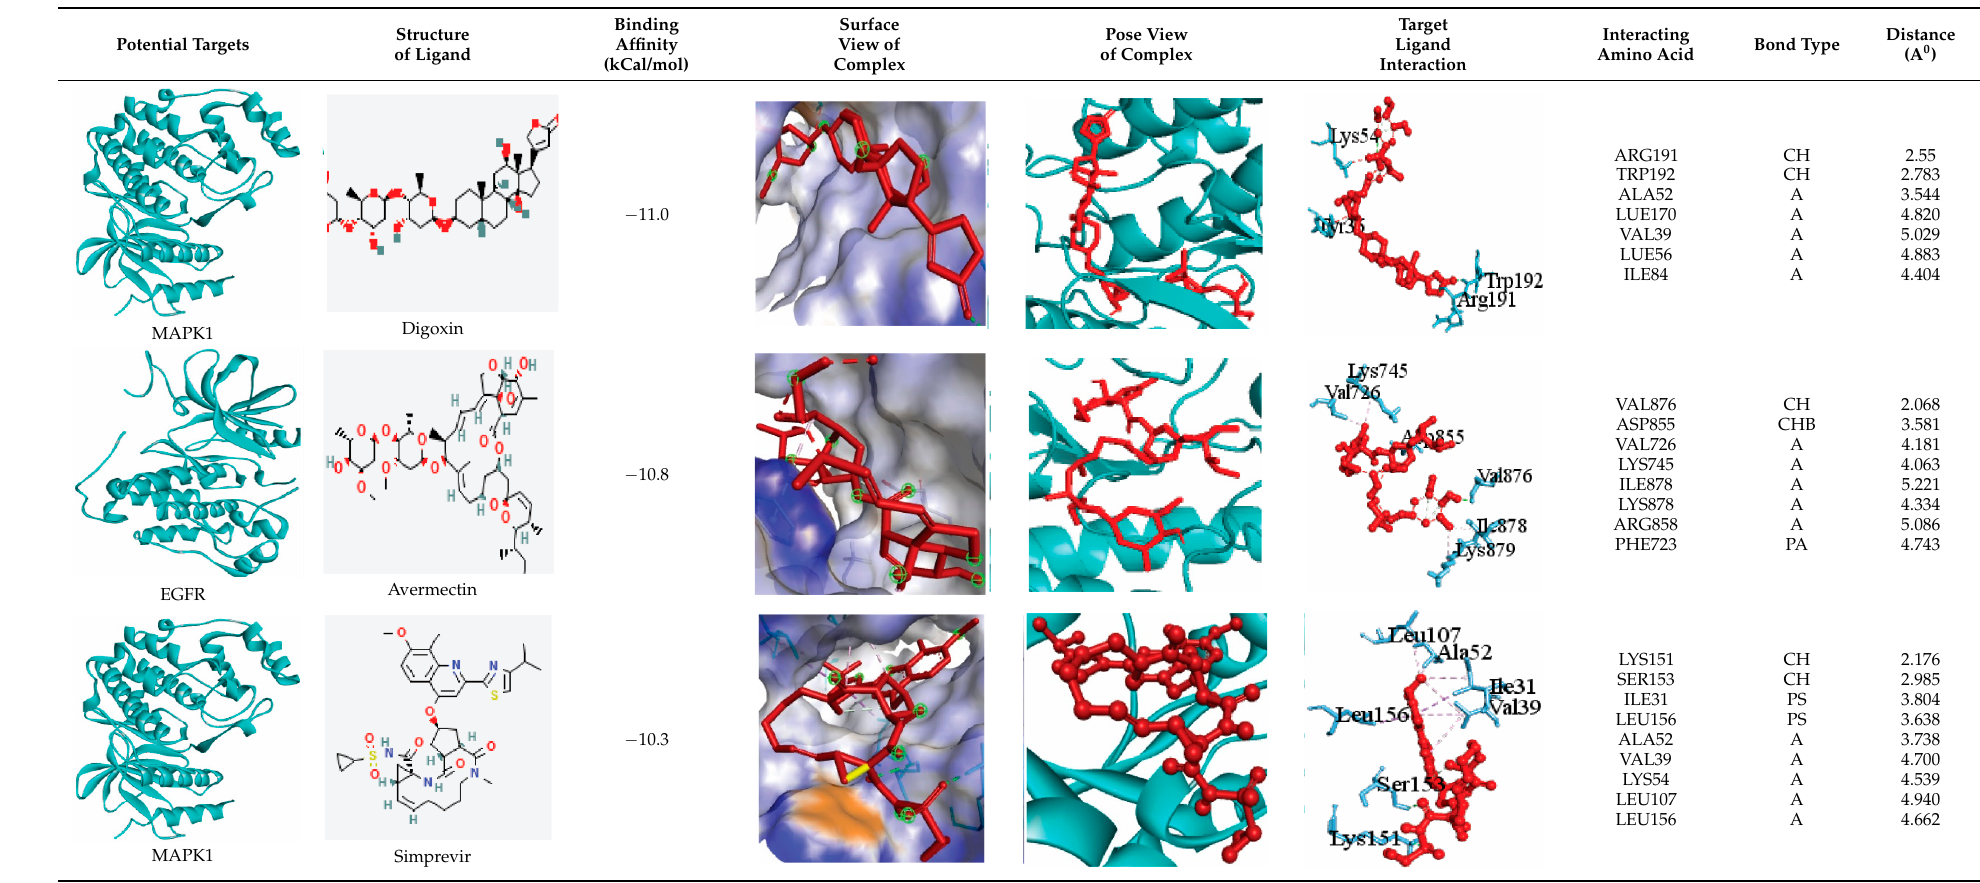
Table 3. Interacting properties of top-ranked three drug-target complexes. The fourth, fifth, and 6th columns displayed the surface view, binding poses, interacting mode, respectively. The 7th, 8th, and 9th columns showed the interacting residues, bonding types, and distances, respectively.